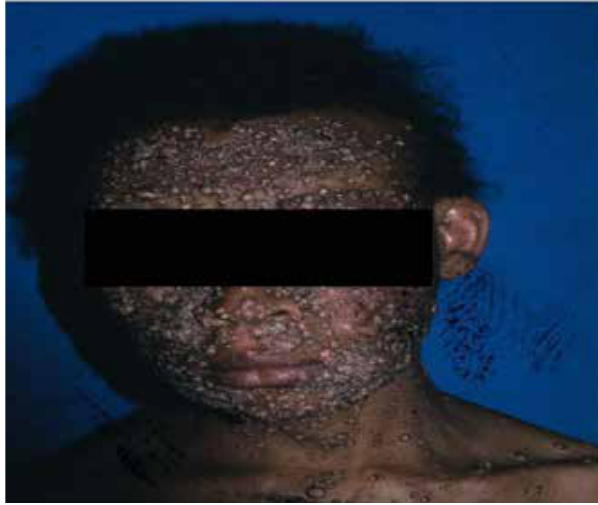
Figure 3. Extensive molluscum contagiosum in an HIV –infected patient